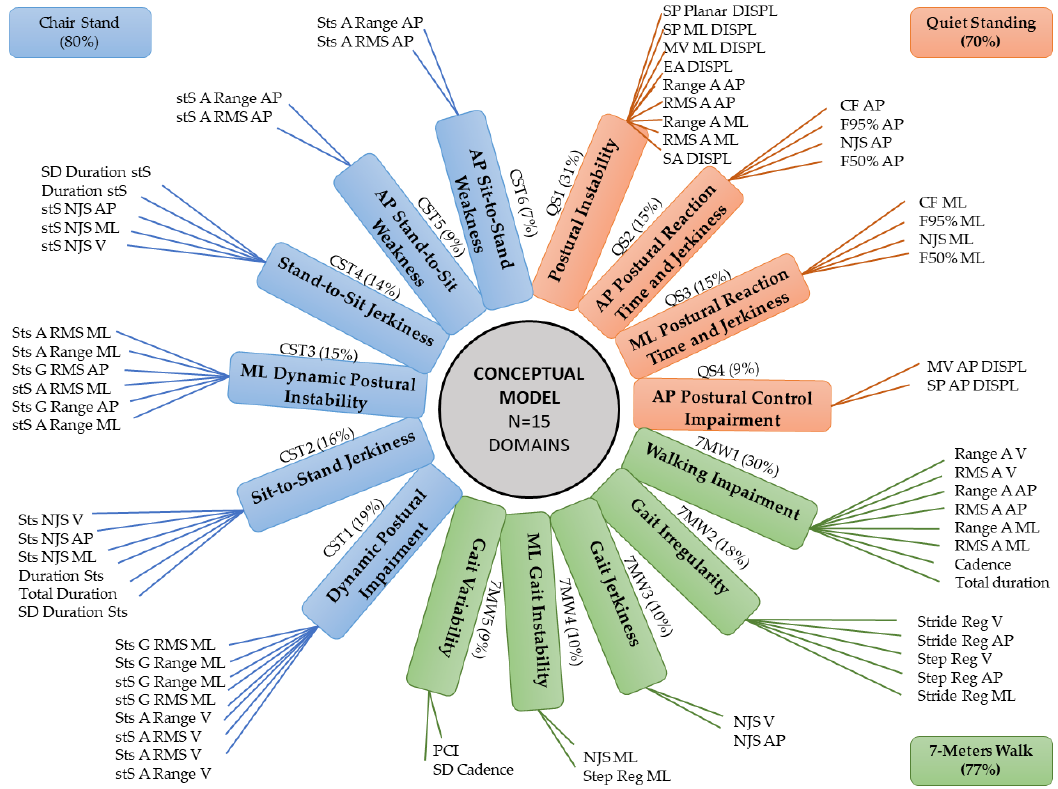
Figure 2. Sensor-based measures contributing to each factor and corresponding domain of the conceptual model for each instrumented test (Orange: Quiet Standing, QS, Green: 7-Meters Walk, 7MW, Blue: Chair Stand, CST). ACRONYMS: A: Accelerometer; AP: Antero-Posterior; CF: Centroidal Frequency; DISPL: displacement; EA: Ellipse Area; FD: Frequency Dispersion; F50%: median frequency, F95%: frequency bandwidth; G: Gyroscope; M: Mean; ML: Medio-Lateral; MV: Mean Velocity; NJS: Normalized Jerk Score; PCI: Phase Coordination Index; Reg: Regularity; RMS: Root Mean Square; SA: Sway Area; SD: Standard Deviation; SE: Spectral Entropy; SP: Sway Path; Sts: Sit to Stand; stS: Stand to Sit; V: